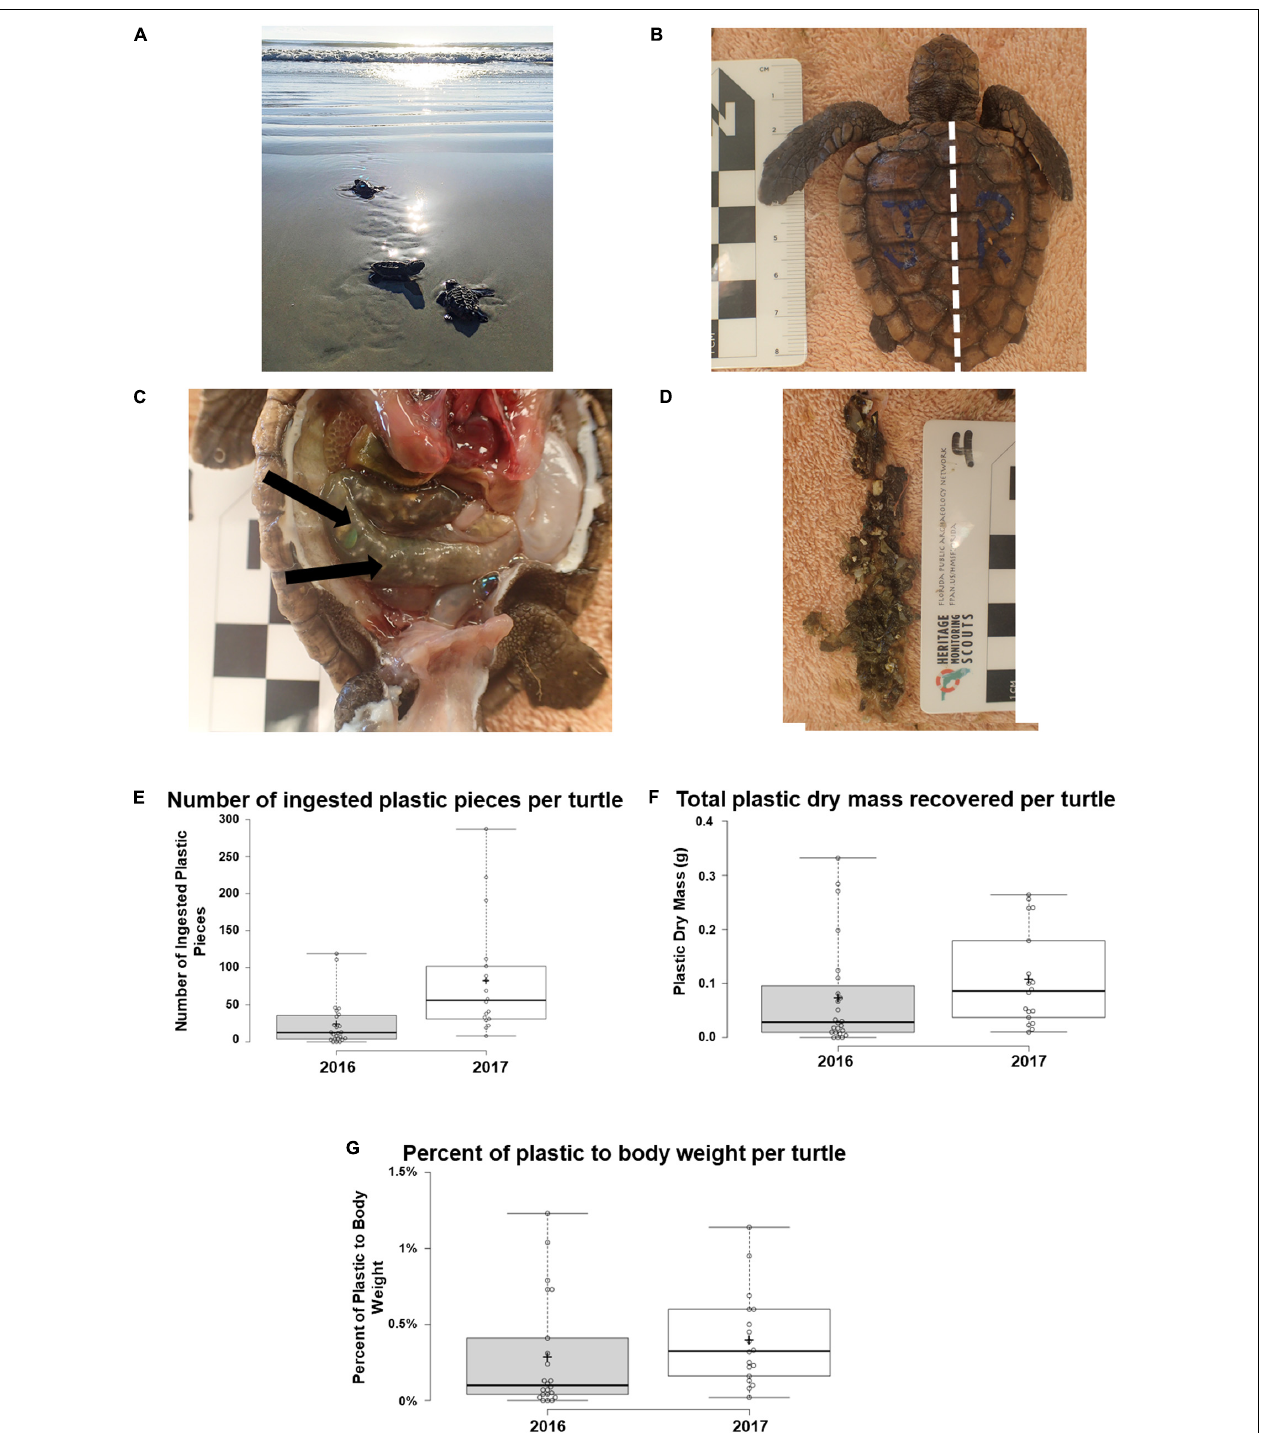
FIGURE 1 | Analysis of plastic pieces identified from post-hatchling washback necropsies. Post-hatchling washback sea turtles. (A) Post-hatchling washback Caretta caretta sea turtles being released back into the Atlantic Ocean, North Florida, after being successfully rehabilitated at the University of Florida’s Whitney Laboratory Sea Turtle Hospital. (B) A deceased loggerhead ( C. caretta ) washback with scale bar, prior to necropsy. Dashed white line indicates maximum straight carapace length. (C) Intact intestinal tract of a loggerhead washback with arrows indicating presence of plastic. (D) Extracted gastrointestinal tract from a loggerhead necropsy, with scale ruler for size comparison, each box on the scale ruler is 1 cm 2 . (E) Comparison of the quantity of plastic pieces ingested by washbacks in 2016, compared to 2017. (F) Comparison of the dry mass of ingested plastic pieces in washbacks in 2016, compared to 2017. (G) Comparison of the proportion of ingested plastic to washback weight in 2016 washbacks, compared with 2017 washbacks. Boxplots were generated using BoxPlotR (Spitzer et al., 2014).